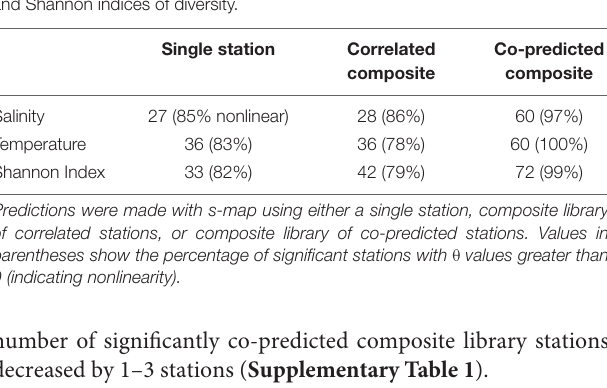
TABLE 3 | Numbers of significantly predicted stations for salinity, temperature, and Shannon indices of